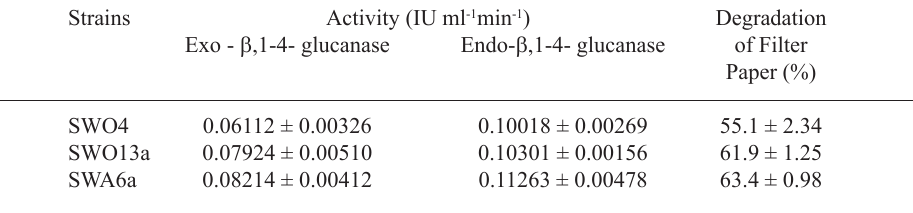
Table 4. The Enzymatic activities and Cellulose Degrading ability of the isolates. The Mean values for each strain is given with SD mentioned. The Degradation of the Filter paper indicates the Cellulolytic potential of the strains Strains Activity (IU ml -1 min -1 ) Degradation Exo - β ,1-4- glucanase Endo- β ,1-4- glucanase of Filter